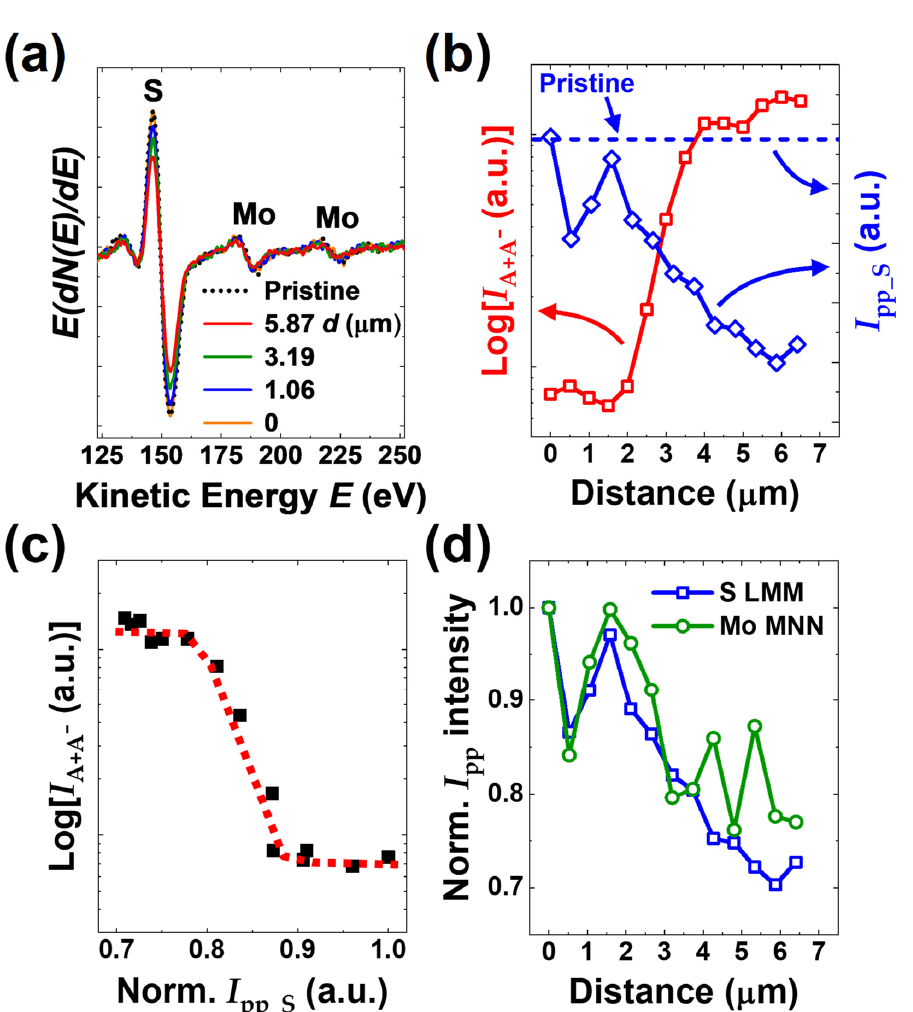
Figure 4. N-AES analyses on the ML-MoS 2 irradiated area selectively using a focused laser beam: ( a ) A set of representative n-AES spectra in the derivative form of E ( dN ( E ) / dE ) vs. E where E and N are the kinetic energy and the number of detected Auger electrons, respectively. These spectra were measured successively by moving the focused e-beam along the white dashed line in Figure 3c from the origin 0 to the spot of d = ~6.41 µ m across the irradiated region. ( b ) The variations in I and the peak-to-peak intensity of S LMM Auger signal, I pp_S . ( c ) The data plot of I A + A − vs. I pp_S normalized to the value at d = 0. To match the two sets of data set for the same d values, I pp_S corresponding to the d values for the I data are given by linear interpolation. Note that the red-dashed curve is drawn only for guidance. ( d ) The changes in normalized peak-to-peak intensities, I pp s, of S LMM (150.0 eV) and Mo MNN (186.5 eV) Auger signals with d . For a comparison, ( a , b ) include the data measured from the un-irradiated region of pristine ML-MoS 2